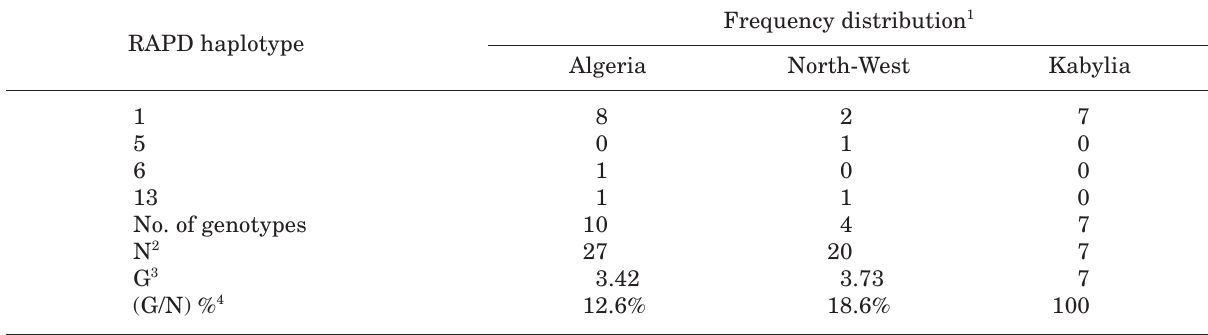
Table 4. Frequency distribution of RAPD haplotypes in Algerian V. dahliae